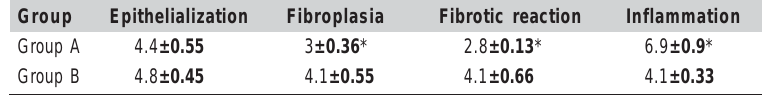
Table 1- Mean±SD histopathological scores following 3 rd mandibular premolar extraction in the groups of the study.